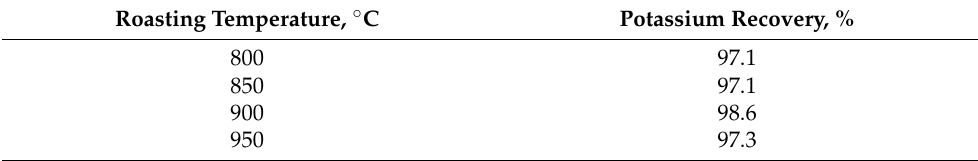
Table 4. Potassium dissolution recoveries after roasting with calcium